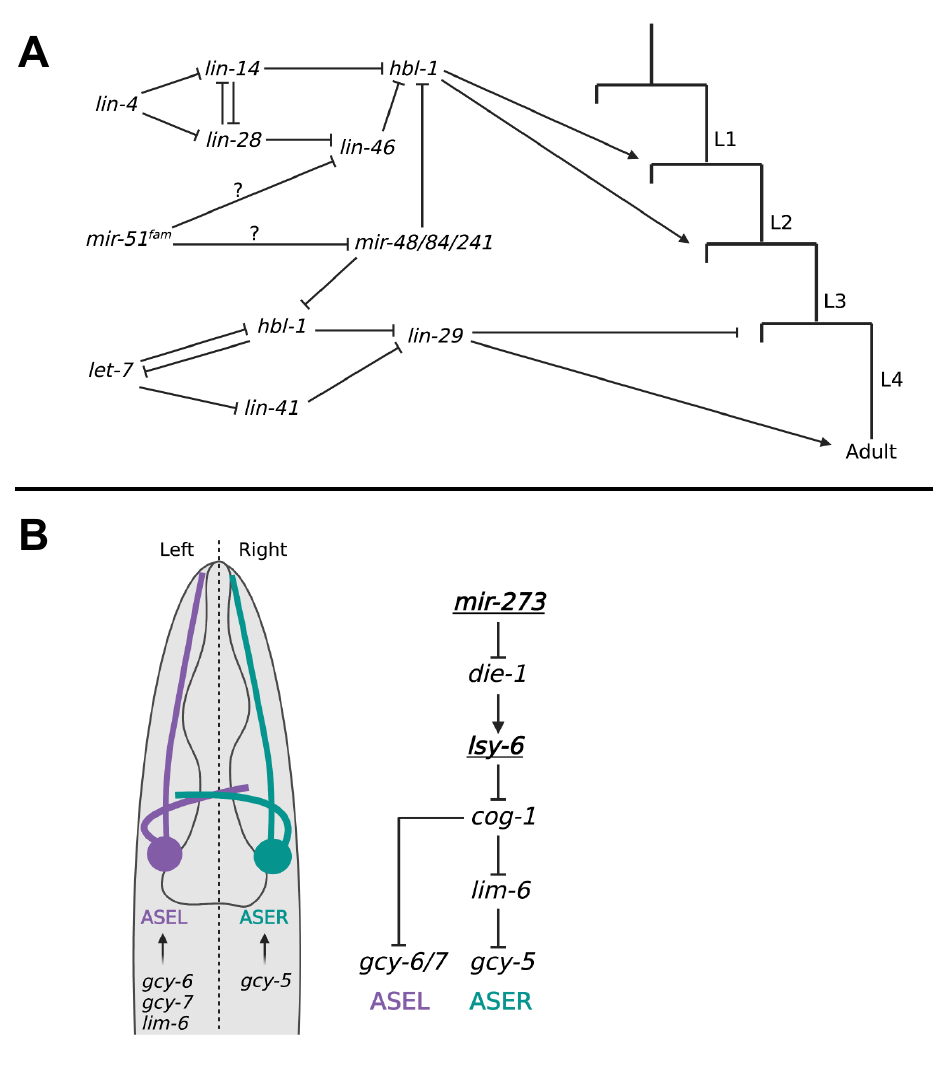
Figure 2. miRNA-mediated regulatory networks during C. elegans larval development. ( A ) The heterochronic pathway: lin-4 and let-7 coordinate cell lineage changes at each larval molt through the repression of several targets. Lin-4 coordinates L1 and L2 cell lineages by repression of lin-14 and lin-28 which in-turn promotes expression of hbl-1 . Let-7 coordinates L3, L4 and adult lineages through the repression of lin-41 and hbl-1 which promotes the expression of lin-29. It is not yet clear how mir-51 fam is involved in this pathway (question marks). Adapted from Refs. [107,108]. ( B ) Two miRNAs, mir-273 and lsy-6 (underlined), control ASEL/R cell identity by regulating the expression of gcy genes required for one cell fate or the other. Expression of lsy-6 promotes the ASEL fate by promoting the expression of gcy-6 and gcy-7 , while expression of mir-273 suppresses lsy-6 and leads to gcy-5 expression and the adoption of the ASER cell fate. Adapted from Refs. [109–111]. The lin-4 miRNA regulates developmental timing at the L1-L2 transition by directly inhibiting lin-14 through binding to its 3′ UTR [103,106]. Lin-14 promotes L1 cell lineages and must be inactivated to proceed past the L1 stage. Failure to do so results in the reiter- ation of L1 cell fates and prevents the worm from proceeding with L2 lineages [103,106].